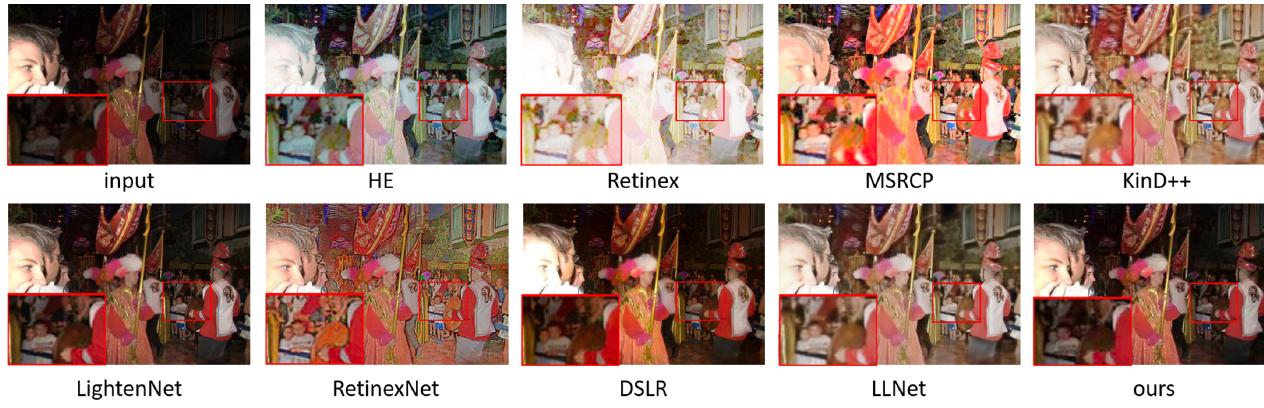
Figure 6. Visual comparison of enhanced renderings of low-illumination images.